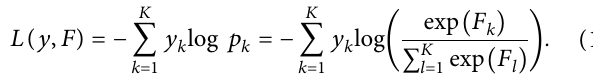
Figure 2: GBDT implementation